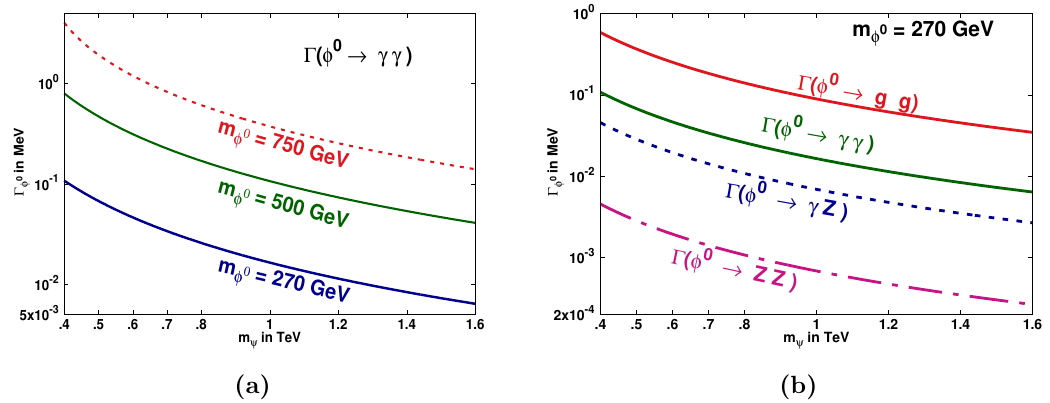
Figure 2. Figure 2a, depicts the variation of the partial decay-widths of the scalar with the VLQ mass m